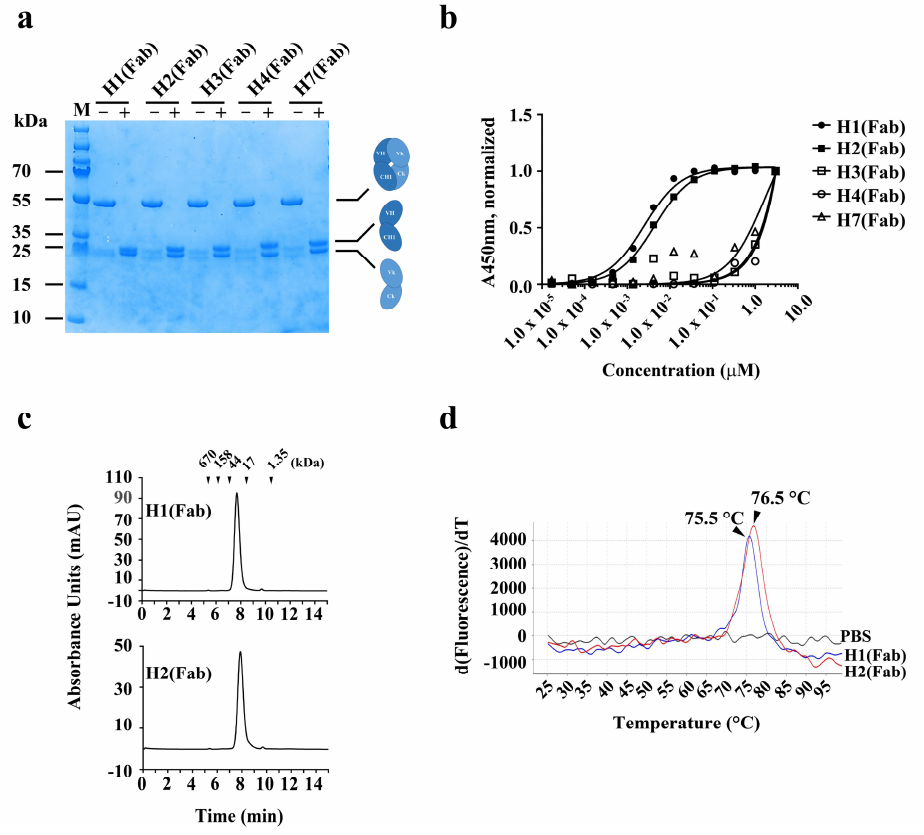
Figure 2. Production and characterization of human anti-hYKL-40 Fabs. ( a ) SDS-PAGE analysis of two human anti-hYKL-40 Fabs, H1 (Fab) and H2 (Fab), purified from periplasmic extracts of E. coli transformed with the indicated expression vectors. + and − indicate with and without the reducing reagent (β-mercaptoethanol), respectively. ( b ) Soluble ELISA of serially diluted H1 (Fab) and H2 (Fab) on immobilized hYKL-40 surfaces to measure their apparent a ffi nities ( EC 50 , nM). ( c ) Size-exclusion chromatography analysis of H1 (Fab) and H2 (Fab). The positions of the molecular mass markers, shown as kDa, on the retention time x -axis are shown above the peaks. ( d ) Protein thermal shift assay of H1 (Fab) and H2 (Fab) to determine their thermal stability ( T m , ◦ C). Fab: antigen-binding fragment; SDS-PAGE: sodium dodecyl sulfate-polyacrylamide gel electrophoresis; M: molecular mass